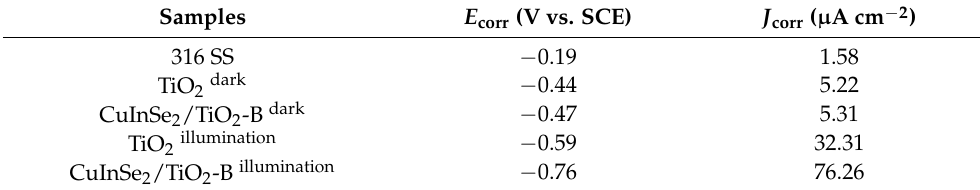
Table 2. Electrochemical parameters obtained by Figure 7a.